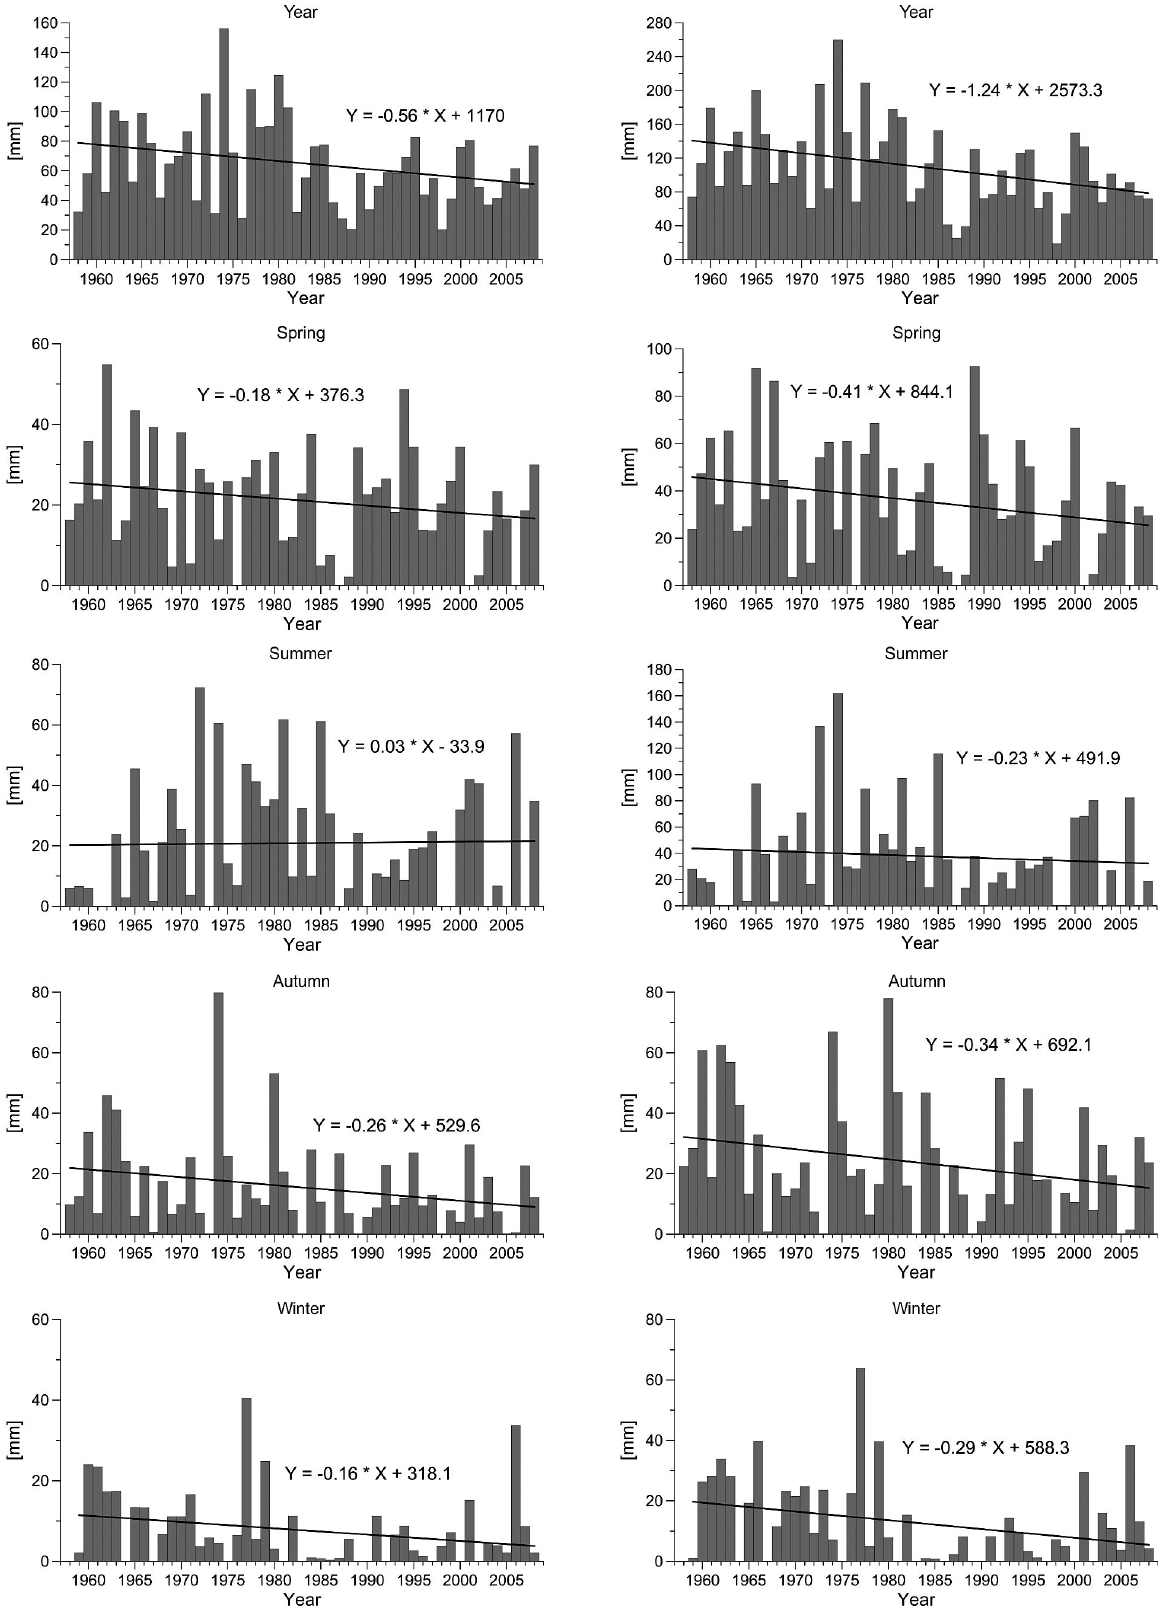
Fig. 9. Mean annual and seasonal MCP totals [mm] in the years 1958–2008 and their linear trends. left panel – mean MCP in the area of Poland, right panel – mean values in the area of mountains and their